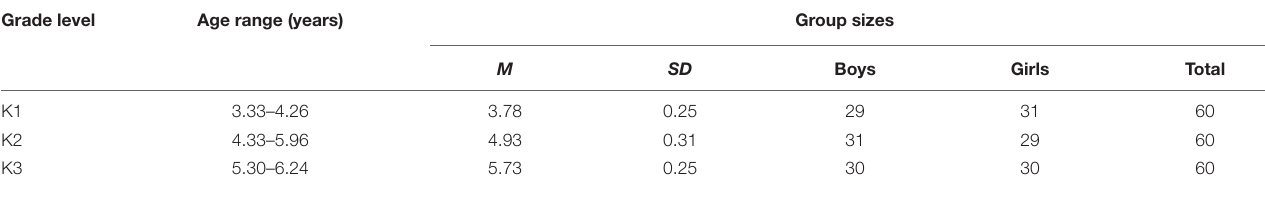
TABLE 1 | Summary of participants’ demographic information ( N = 180). Grade